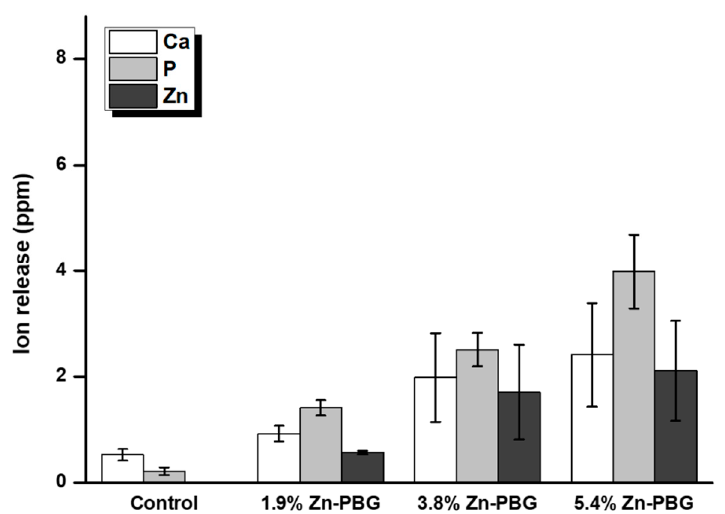
Figure 4. Concentrations of the major ions (Ca, P, and Zn) released from samples.